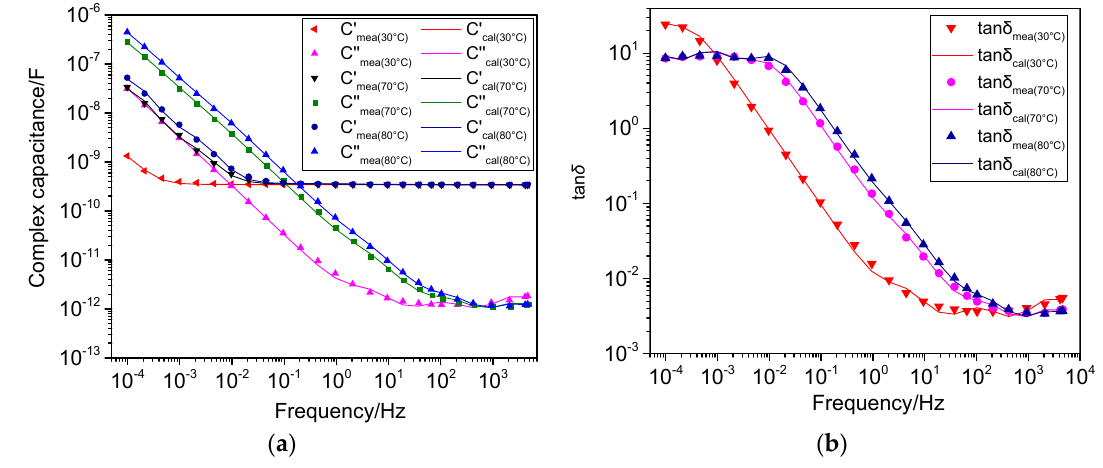
Table 4. The identified resistance and capacitance in EDM at 80 °C.